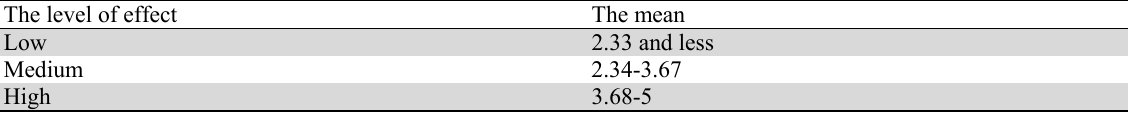
Scale determine the relative importance of the mean The level of